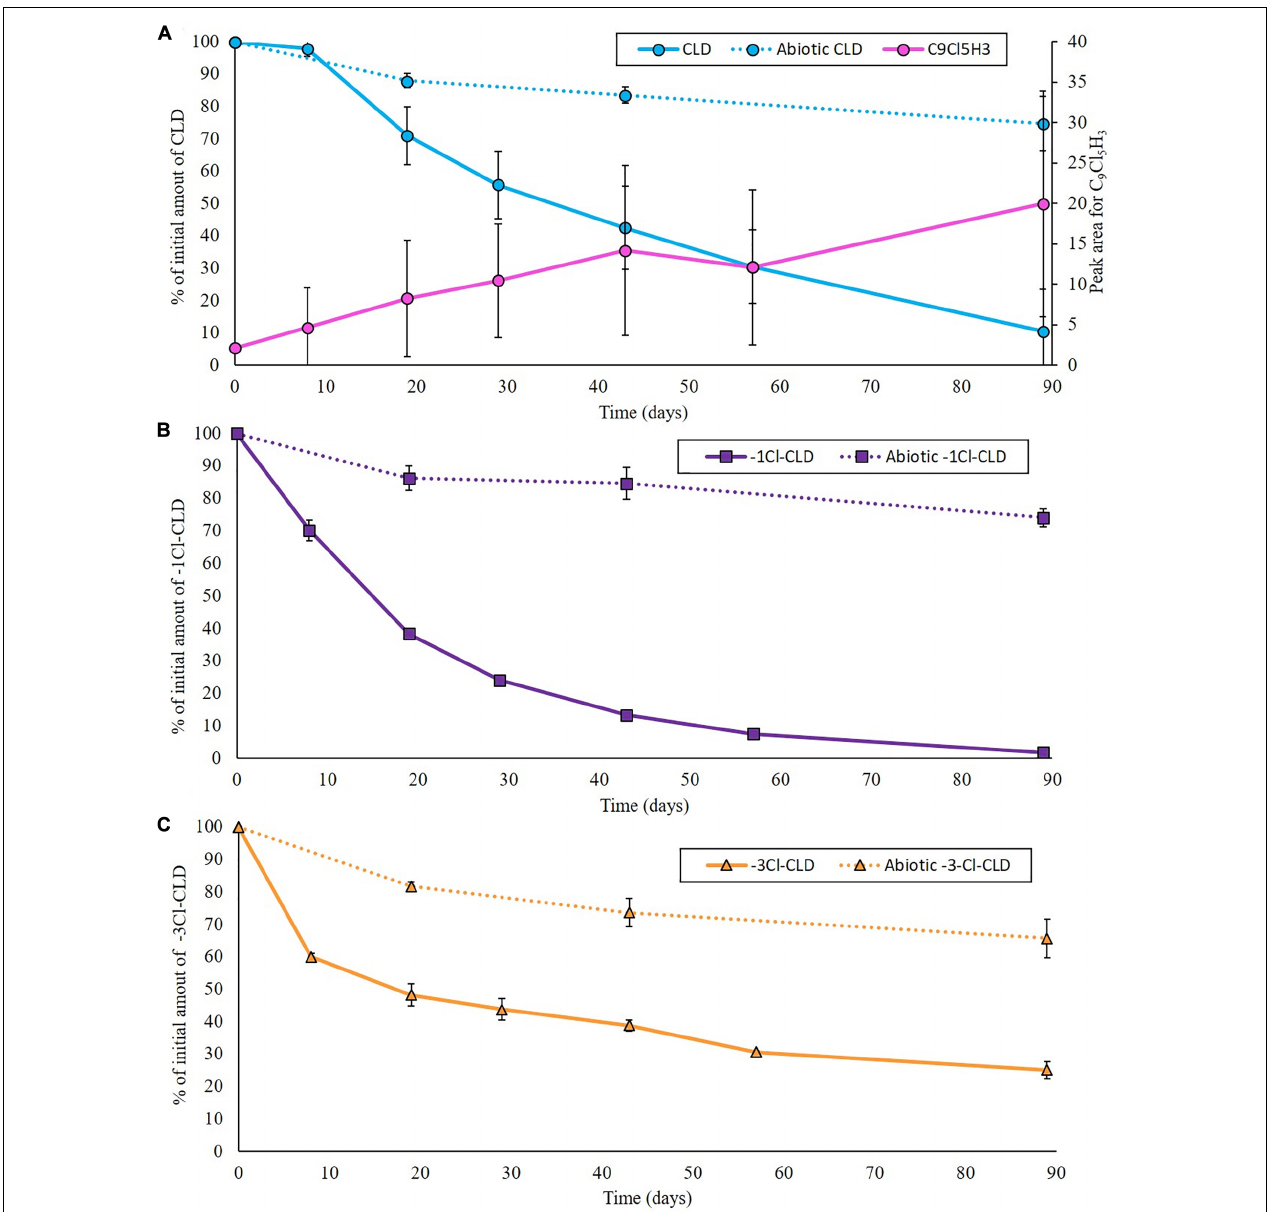
FIGURE 1 | Evolution of CLD (A) , -1Cl-CLD (B) , and -3Cl-CLD (C) over time in biotic (full lines) and abiotic (dotted lines) incubations expressed as the remaining percentage in the solution and of the peak area measured for C 9 Cl 5 H 3 , which increased over time in the batches containing CLD. Data represent the average of three replicates, and error bars are the standard